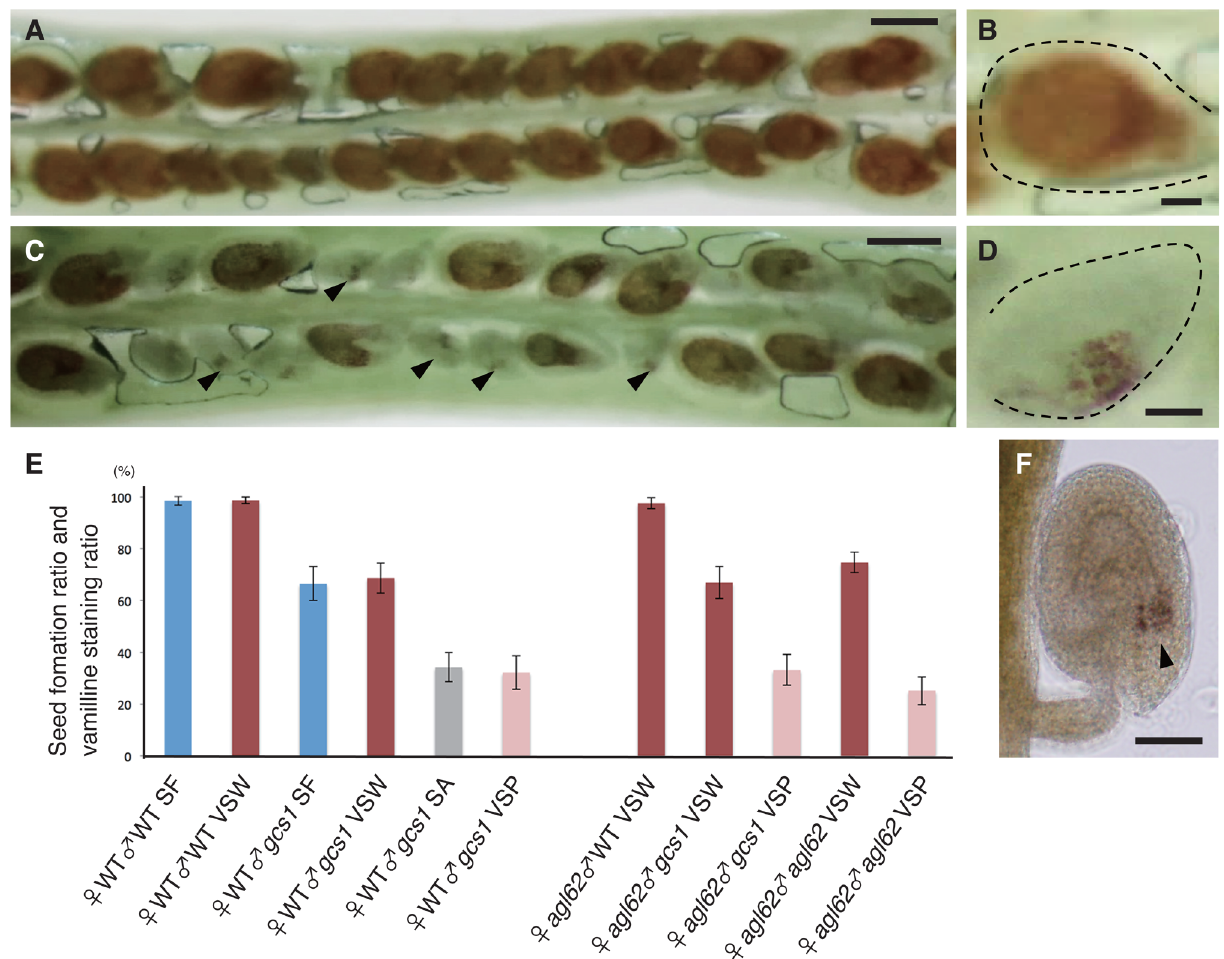
Figure 1. Pollen tube content (PTC) is sufficient to initiate seed coat formation. ( A ) Wild-type (WT) silique crossed with WT pollen and stained with vanillin. Almost all ovules were stained. Bar: 300µm. ( B ) Representative image of whole seed coat staining. Bar: 50µm. ( C ) WT silique crossed with gcs1 pollen and stained with vanillin. Several ovules had partial seed coat (arrowhead) staining. Bar: 300µm. ( D ) Representative image of partial seed coat staining. Bar: 50 µm. ( E ) Comparison of seed formation ratio and vanillin staining ratio. ♀ WT ♂ WT seed formation ratio (SF) indicates that a WT silique was crossed with WT pollen and the seed formation ratio was calculated. ♀ WT ♂ WT vanillin stained in whole seed coat (VSW) indicates that a WT silique was crossed with WT pollen and the whole seed coat staining ratio was calculated. ♀ agl62 ♂ WT VSW indicates that an agl62 /+ silique was crossed with WT pollen and the whole seed coat staining ratio was calculated. ♀ WT ♂ gcs1 SF indicates that a WT silique was crossed with gcs1 /+ pollen and the seed formation ratio was calculated. ♀ WT ♂ gcs1 VSW indicates that a WT silique was crossed with gcs1 /+ pollen and the whole seed coat staining ratio was calculated. ♀ agl62 ♂ gcs1 VSW indicates that an agl62 /+ silique was crossed with gcs1 /+ pollen and the whole seed coat staining ratio was calculated. ♀ WT ♂ gcs1 seed abortion ratio (SA) indicates that a WT silique was crossed by gcs1 /+ pollen and the seed abortion ratio was calculated. ♀ WT ♂ gcs1 (vanillin stained in partial seed coat) indicates that a WT silique was crossed with gcs1 /+ pollen and the partial seed coat staining ratio was calculated. ♀ agl62 ♂ gcs1 VSP indicates that an agl62 /+ silique was crossed with gcs1 /+ pollen and the partial seed coat staining ratio was calculated. ♀ agl62 ♂ agl62 VSW indicates that an agl62 /+ silique was crossed with agl62 /+ pollen and the whole seed coat staining ratio was calculated. ♀ agl62 ♂ agl62 VSP indicates that an agl62 /+ silique was crossed with agl62 /+ pollen and the partial seed coat staining ratio was calculated. Blue bars indicate SF (Seed formation ratio). Dark red bars indicate VSW (vanillin stained in whole seed coat). Gray bar indicates SA (Seed abortion ratio). Pink bars indicate VSP (vanillin stained in partial seed coat). ( F ) A ♀ agl62 ♂ agl62 VSP ovule. The arrowhead indicates the vanillin- stained zone. Bar: 50 µm. For normal seed coat initiation, fertilization is not required; however, for completion of normal seed coat formation, both normal fertilization and normal endosperm development are